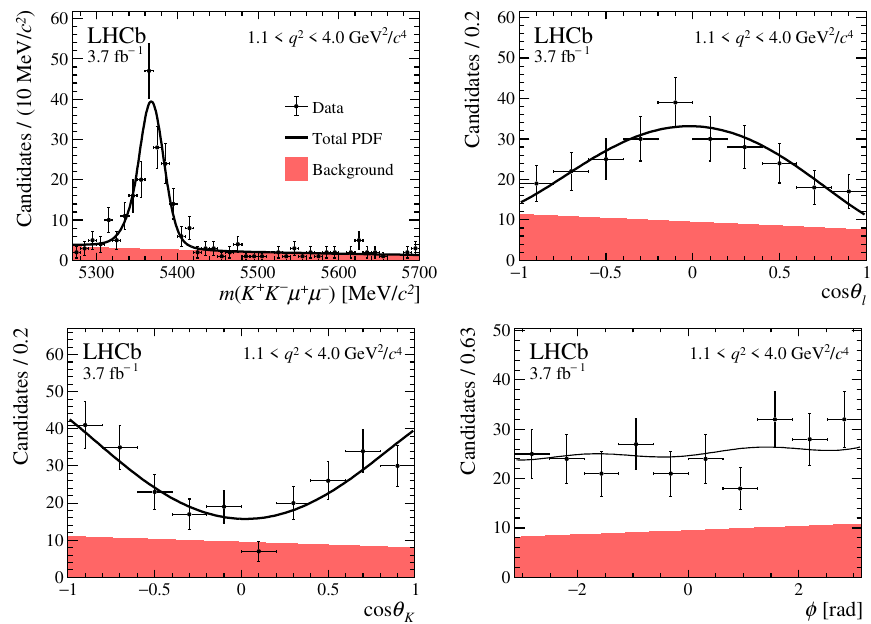
Figure 17 . Mass and angular distributions of B 0 1 . 1 < q 2 < 4 . 0 GeV 2 /c 4 for data taken in 2017–2018. The data are overlaid with the projections of the fitted